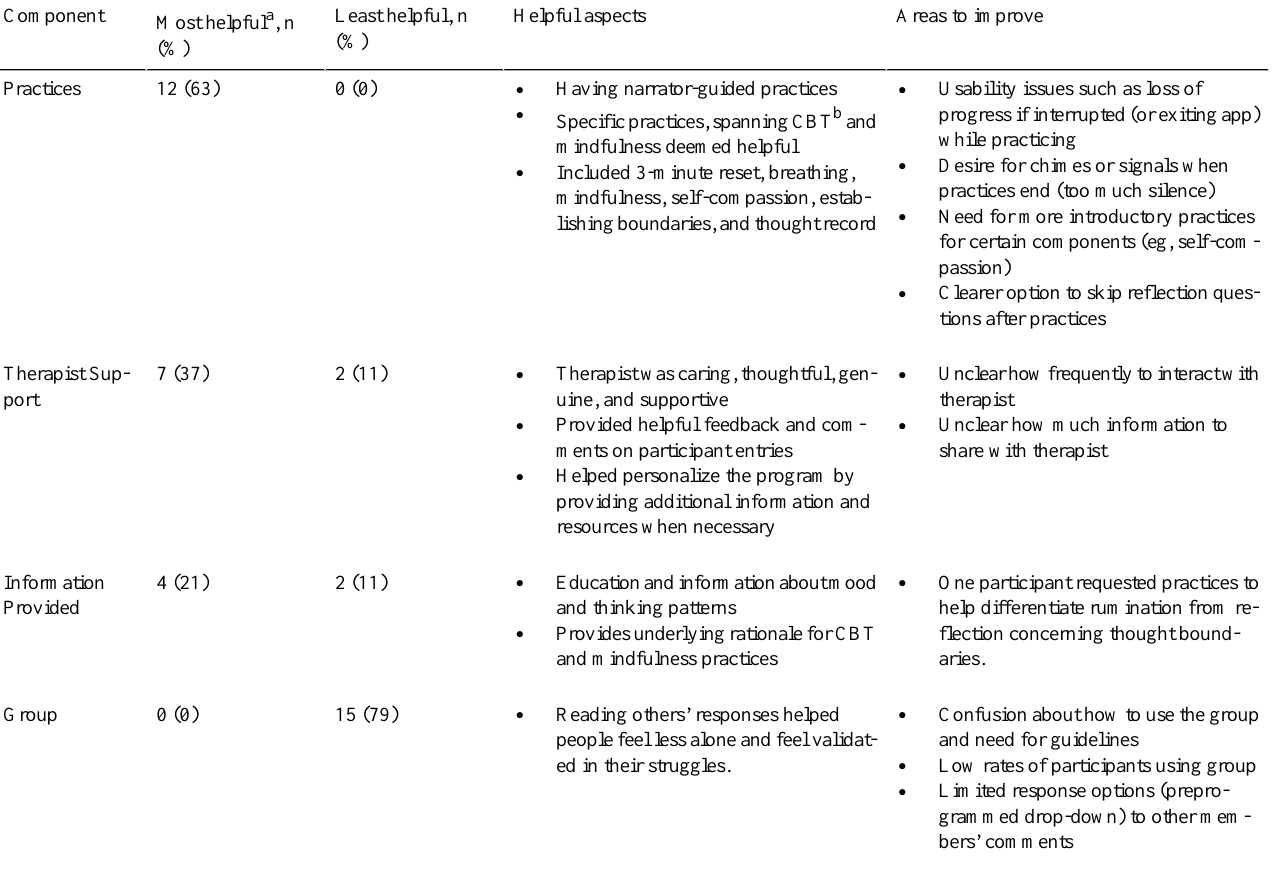
Table 3. Mixed methods evaluation of program components